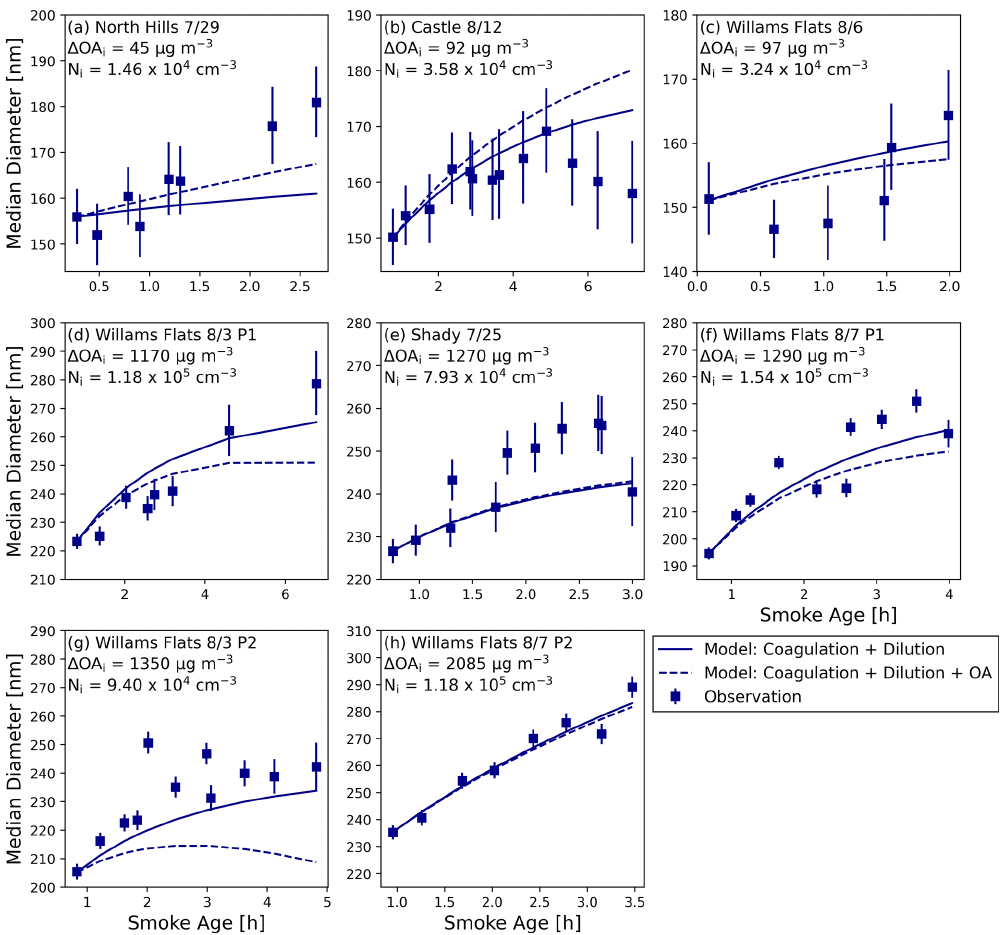
Figure 7. The observed median diameter ( D pm ) (points), modeled D pm due to coagulation and dilution alone (solid line), and modeled D pm due to coagulation and dilution plus diameter changes due to OA evaporation/condensation (dashed line) as a function of smoke age for each of the eight smoke plumes used in our analysis. The error bars represent the standard deviation of D pm within the transect. In each panel is (cid:49) OA i , and the aerosol number concentration of particles between 50nm and 800nm measured at the first transect ( N i ). Panels (a) – (h) are in order of increasing (cid:49) OA i